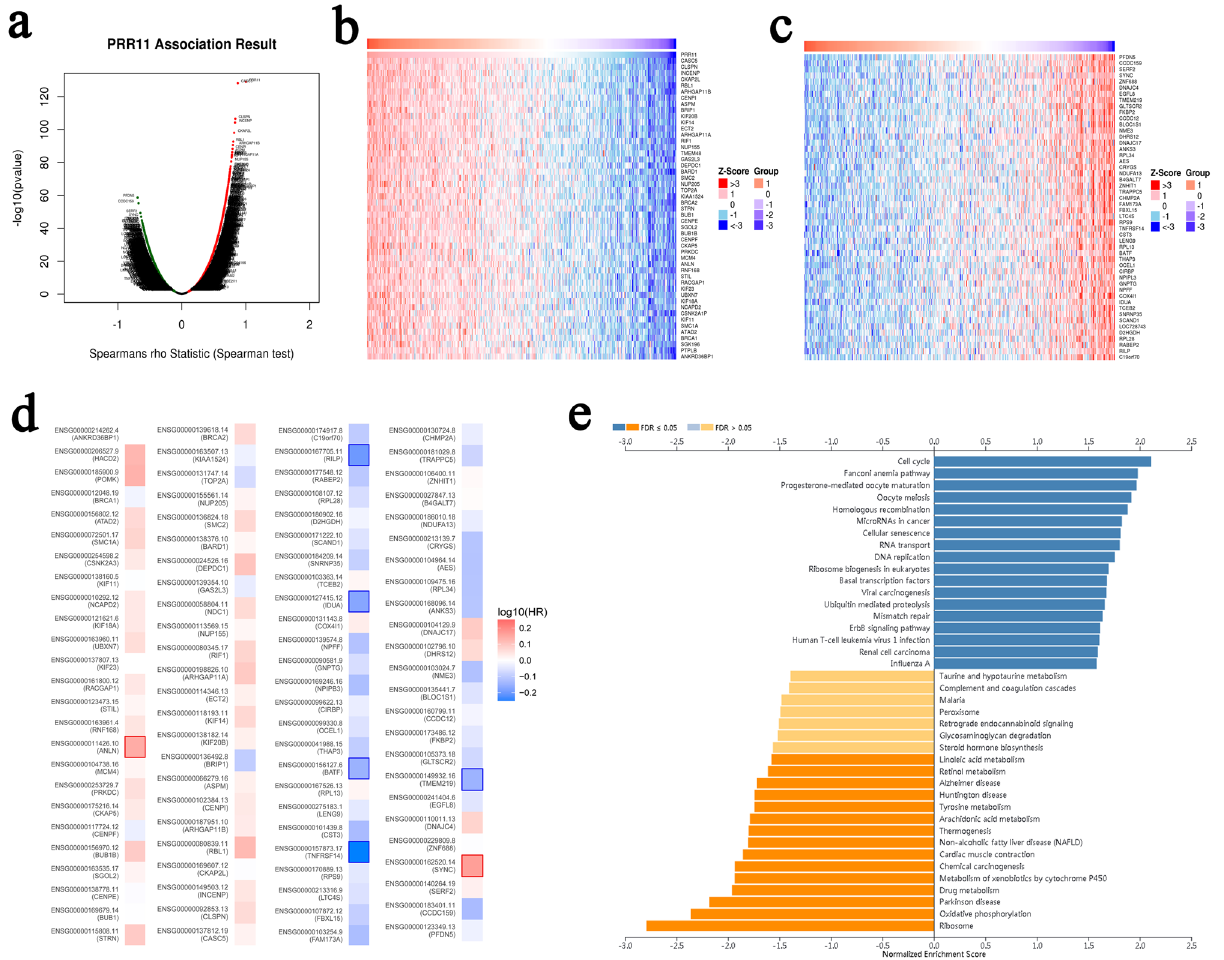
Figure 5. PRR11 coexpression network in BLCA from LinkedOmics database. ( a ) All genes associated with PRR11 in BLCA cohort, red dots positively correlated with PRR11, and green dots negatively correlated. Heat map of the top 50 genes positively ( b ) and negatively ( c ) correlated with PRR11 in BLCA. Red represents positively linked genes and blue represents negatively linked genes. The gene expression heatmap is realized by LinkedOmics database (http:// www. linke domics. org/ login. php). ( d ) Survival map of the top 50 genes positively and negatively associated with PRR11 in BLCA. The survival heatmap is realized by GEPIA Database (http:// gepia. cancer- pku. cn/ index. html). ( e ) PRR11 of KEGG pathway enrichment analysis in BLCA cohort.